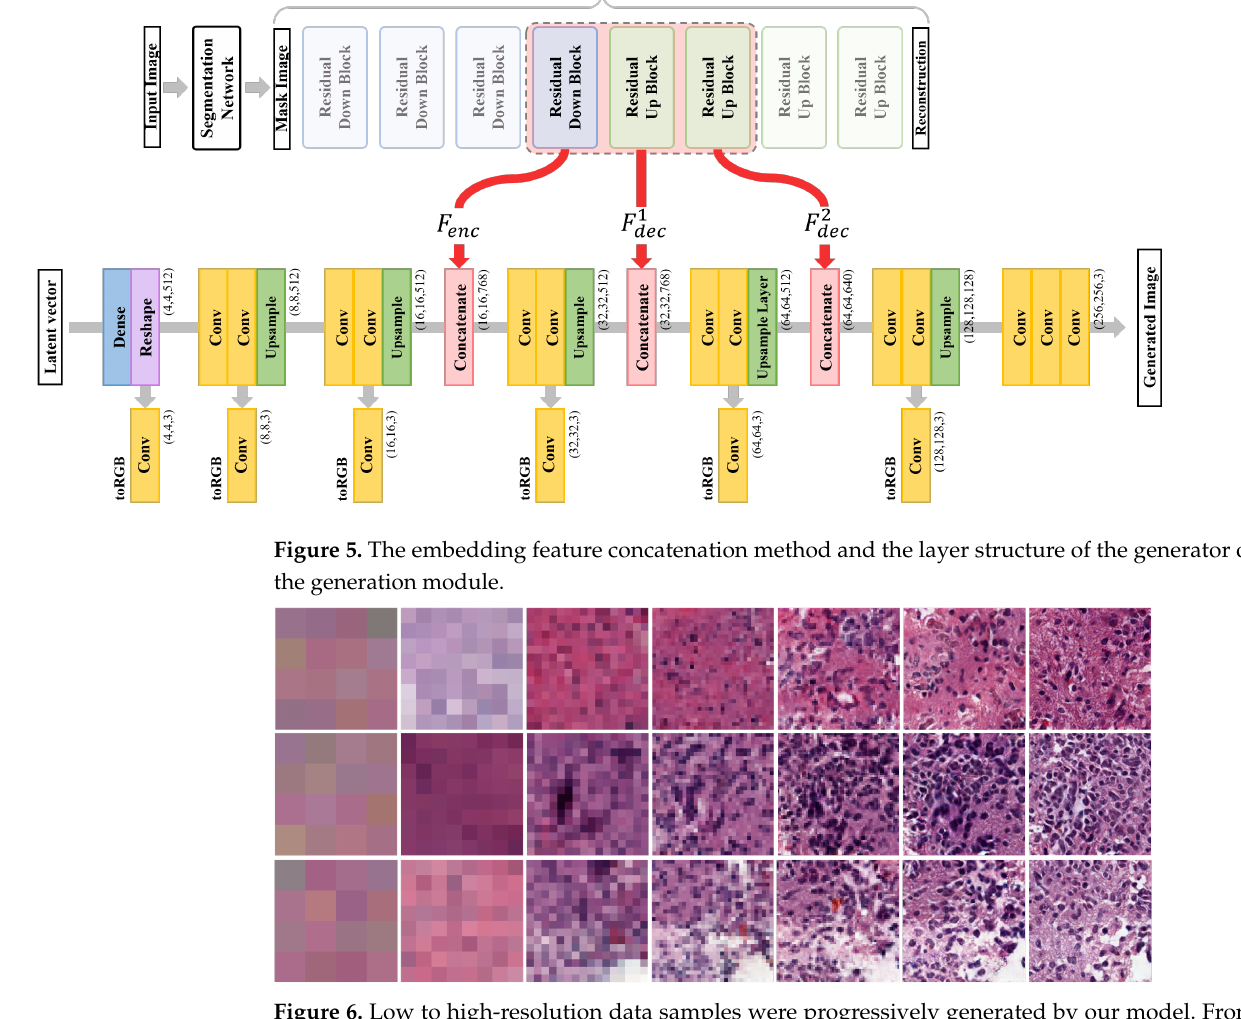
Figure 6. Low to high-resolution data samples were progressively generated by our model. From 4 × 4 ( leftmost ) to 256 × 256 ( rightmost ).